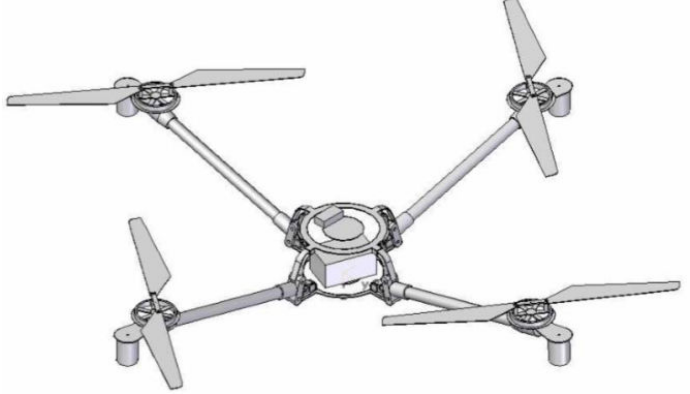
Figure 2. Draganflyer X-Pro quadrotor used for simulation, ref.